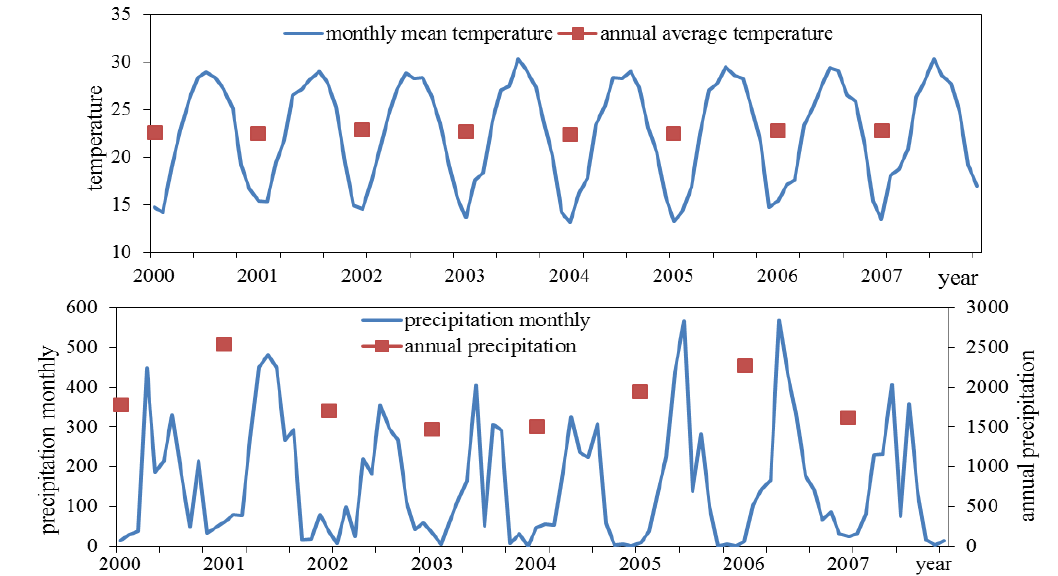
Figure 7. Annual average temperature and total precipitation in Guangzhou from 2000 to 2007.